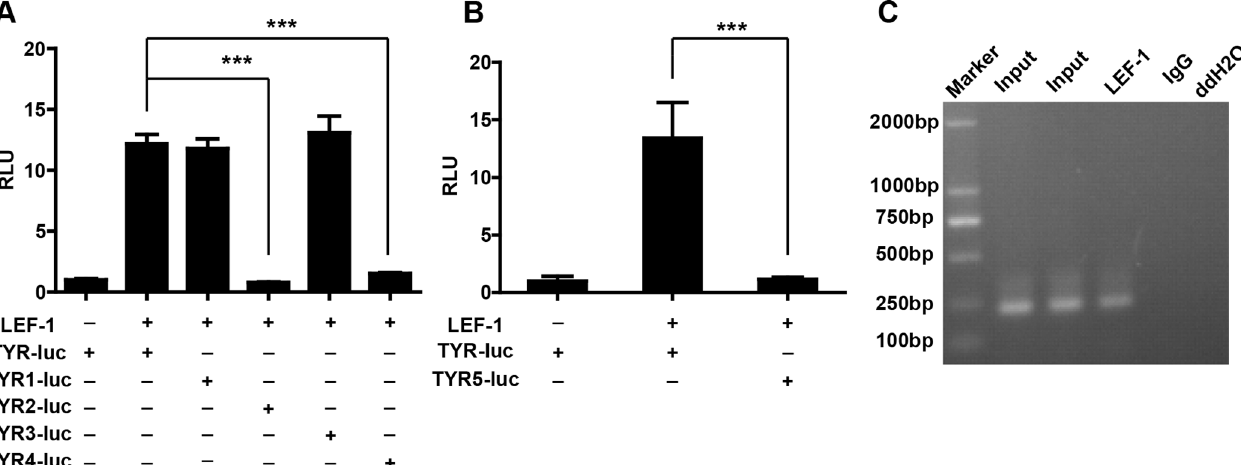
Fig 3. The proximal region (positions -56 bp to -50 bp) of the TYR promoter was required for LEF-1-mediated gene expression of the TYR promoter. A, B Transcriptional activity of LEF-1 on various TYR deleted or mutated promoters ( TYR5 ) by luciferase assay. UACC903 cells were transiently transfected with each reporter plasmid (5 ng) and the LEF-1 expression plasmid (20 ng). Cells were lysed and luciferase activity was detected 48 h after transfection. ( *** p < 0.001 by one-way ANOVA with Dunnett ’ s multiple comparison tests compared to basal activity; ### p < 0.001; ns, not significant compared to the value from the TYR promoter and LEF-1 by an unpaired Student ’ s t-test). C Binding of LEF-1 to the TYR promoter was analyzed by ChIP assay by precipitating with the indicated antibodies and normal mouse IgG, which was used as the negative control. The crosslinks were reversed at 65°C for 4 h and digested with proteinase K (Sigma-Aldrich) for 1 h at 45°C to remove proteins. A 230-bp TYR promoter fragment (-28 to -257 bp) was amplified by PCR, and the products were subjected to 2% agarose gel electrophoresis. Ten percent of the chromatin DNA used for immunoprecipitation was subjected to PCR and is indicated as ‘ input ’ . The results were representative of at least three independent experiments.